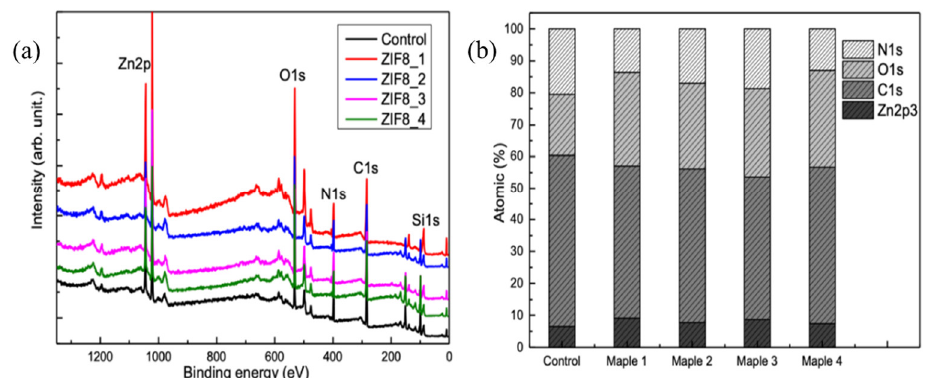
Figure 4. XPS survey spectra of ZIF-8 control and MAPLE deposited films presented using both changes in intensity ( a ), as well as atomic ratios ( b ).